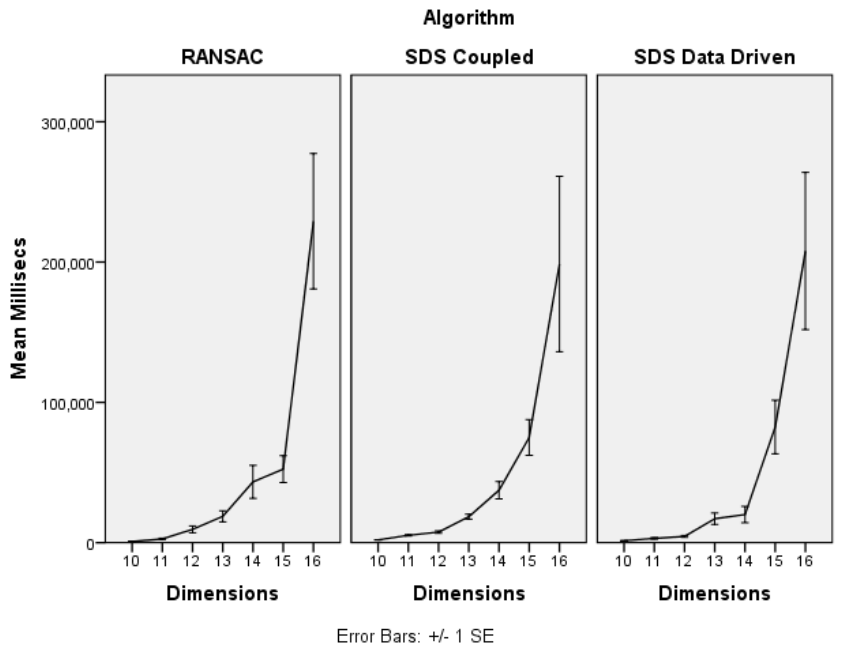
Figure 3. Hyperplane estimation dimension trials: convergence